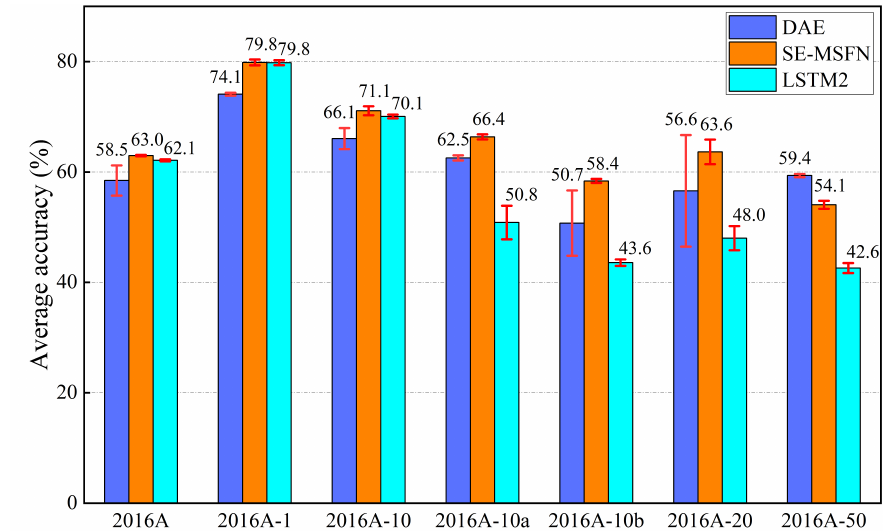
Figure 4. Comparison of recognition performance of the baseline models on five datasets.